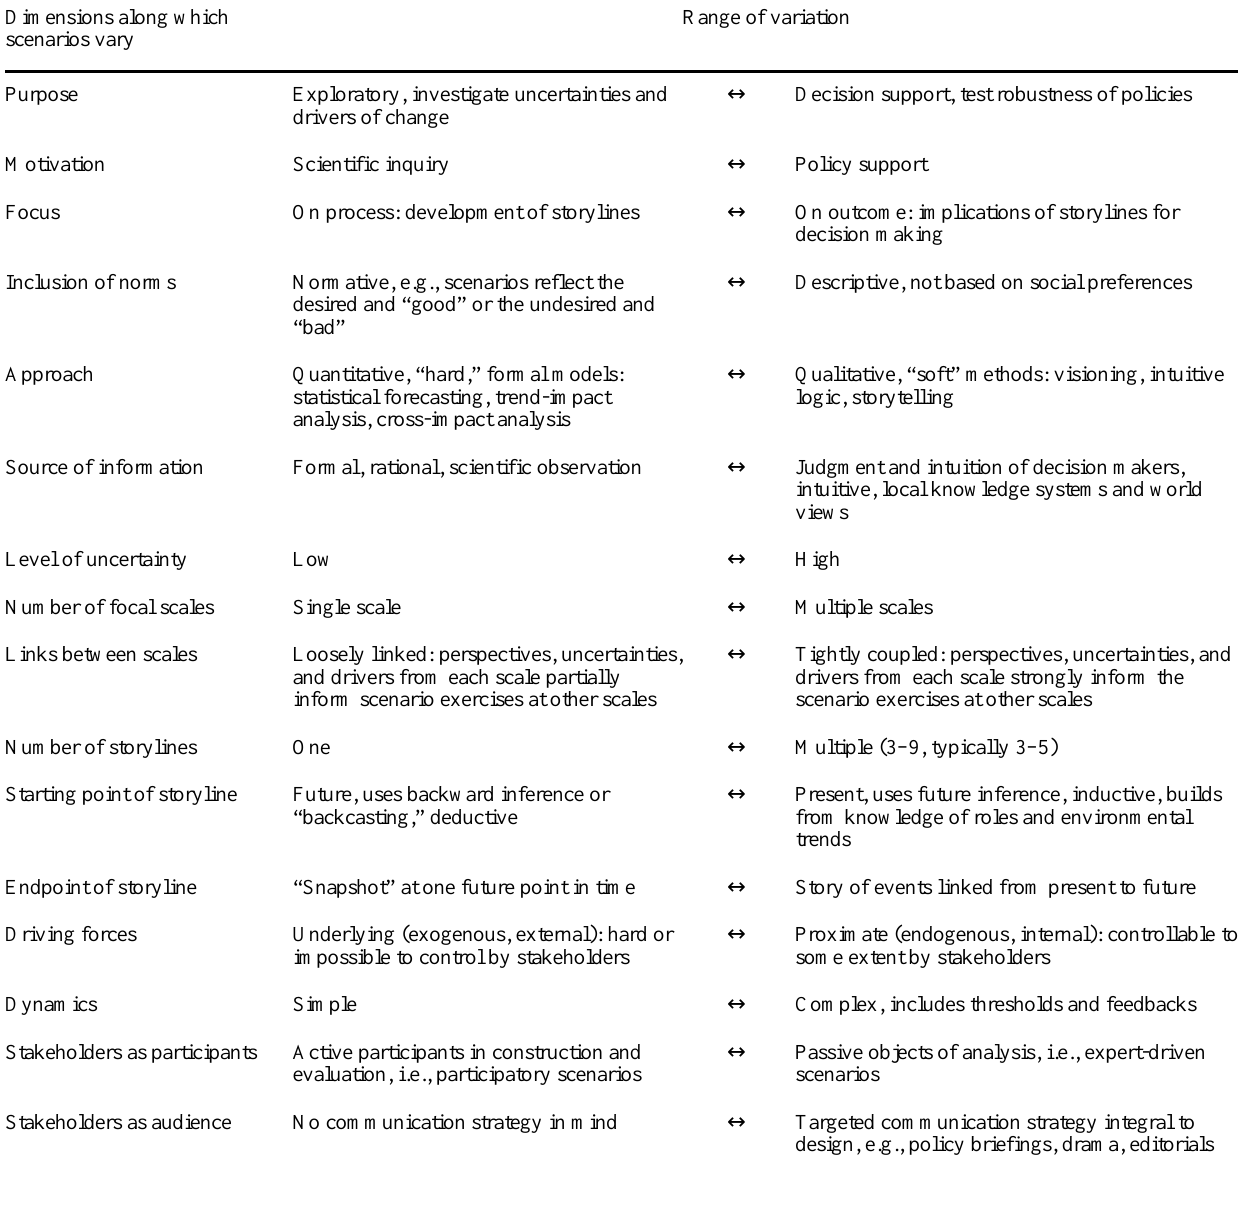
Table 1 . Several major axes of variation characterize the diversity of purpose and approaches adopted in scenario exercises. The two columns represent the ends of a continuum. Most scenario exercises lie between these endpoints. Note that the different axes do not necessarily co-vary, i.e., the elements in each column need not co-occur. For example, an exploratory scenario could be motivated by either scientific inquiry or policy support (table adapted from Ducot and Lubben 1980, Bunn and Salo 1993, Wollenberg et al. 2000, van Notten et al.